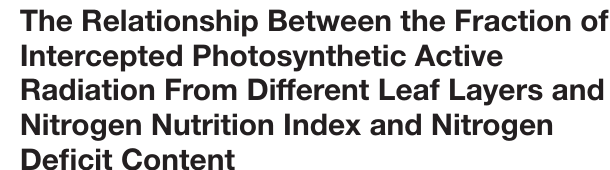
There was a significantly negative and positive relationship between FIPAR, NDC, and NNI from different leaf